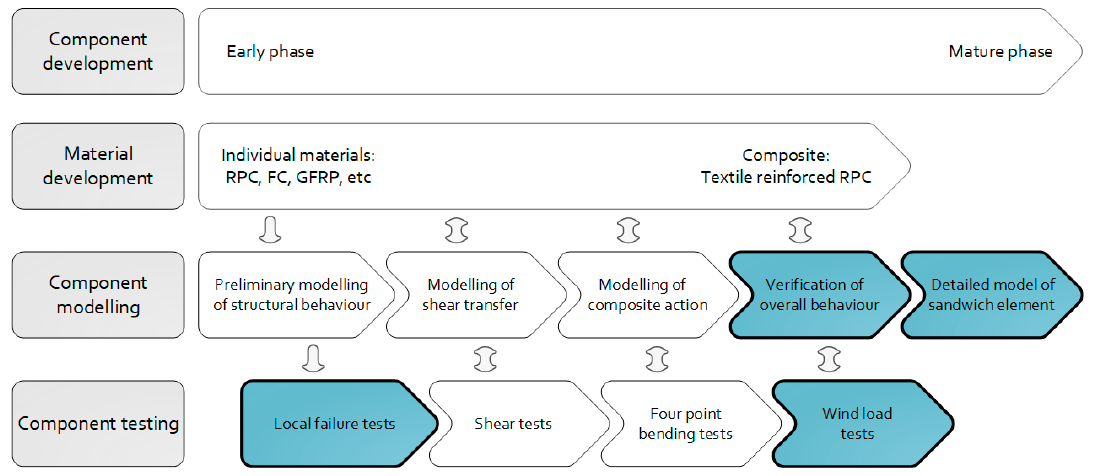
Figure 2. Workflow diagram referring to the component testing and modelling (highlighted boxes are principally covered in this paper). RPC: reactive powder concrete; FC: foam concrete; GFRP: glass fibre reinforced polymer.